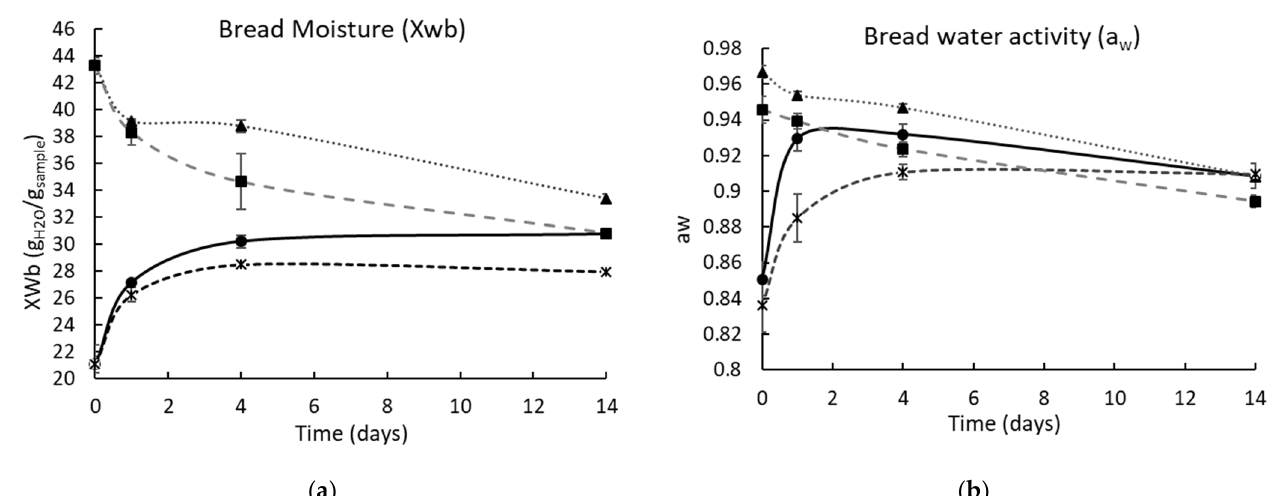
Figure 7. Moisture ( a ) and water activity ( b ) of the bread crust and crumb for 14 days of storage at 25 °C. Control crust (-•-); control crumb (- ▲ -); BPD48h crust (-*-); and BPD48h crumb (- ◾ -). BPD48h is bread incorporated with fermented sourdough with Lactiplantibacillus plantarum NRRL B-4496 for 48 h.